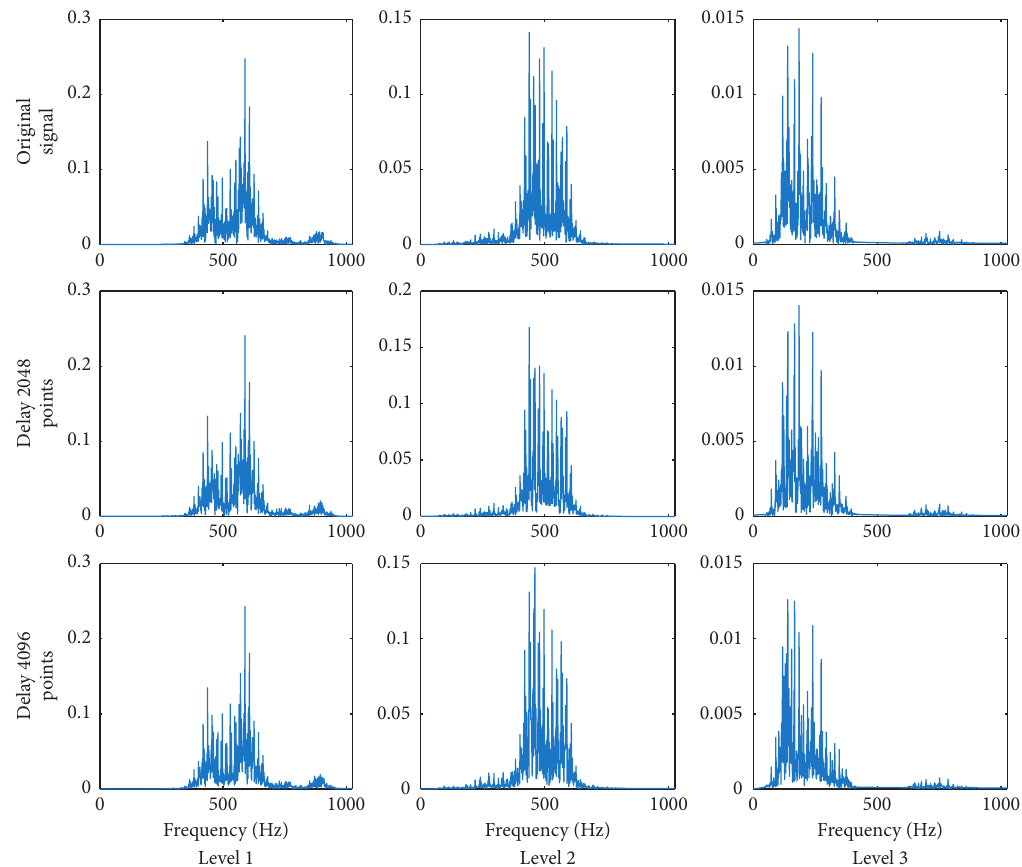
Figure 7: The first three levels of Fourier spectrum of the wavelet components of original signal and its delay series obtained by Db5 wavelet.